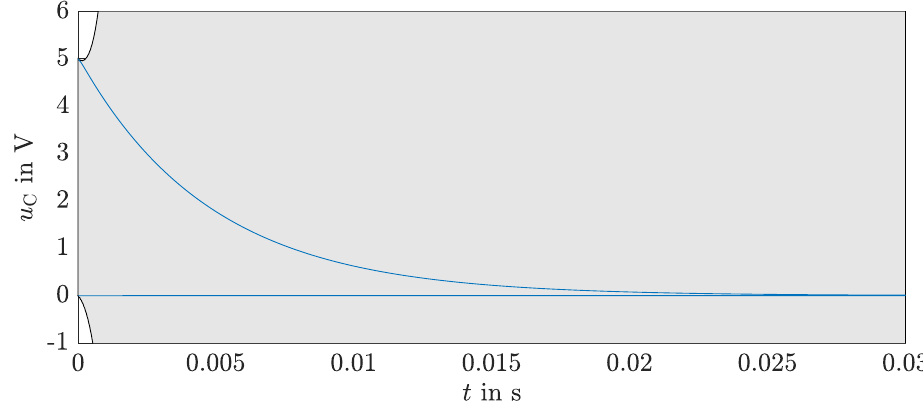
Figure 7. Comparison of the presented method relying on cooperativity in blue and a state-of-the-art Taylor series prediction in gray for the state variable u C .